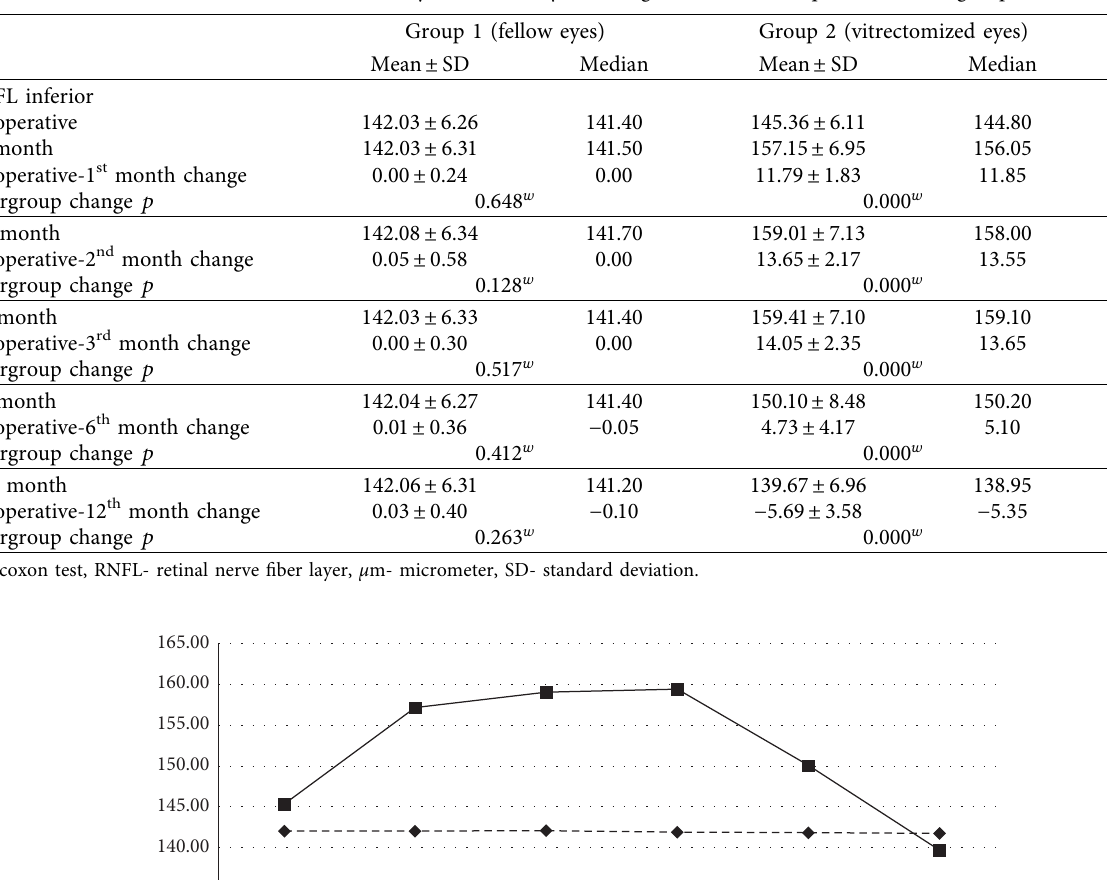
Table 3: Retinal nerve fiber layer thickness ( μ m) change in the inferior quadrant of the groups.